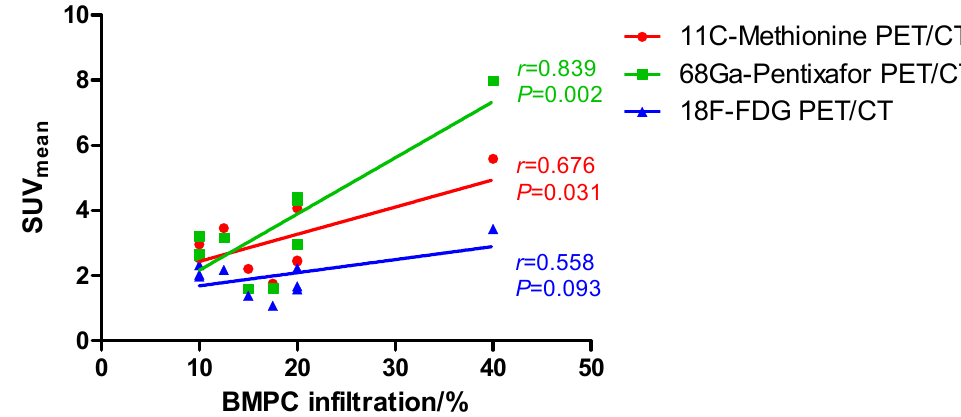
Figure 1. Correlation between bone marrow plasma cell (BMPC) infiltration and mean standardized uptake value (SUV mean ) of lumbar vertebrae (LV) L2-L4 on 11C-Methionine, 68Ga-Pentixafor, and 18F-FDG PET/CT: A significant correlation between BMPC infiltration and SUV mean of LV L2-L4 was shown by 11C-Methionine PET/CT (Pearson’s r = 0.676, p = 0.031, red) and 68Ga-Pentixafor (Pearson’s r = 0.839, p = 0.002, green) PET/CT. In contrast, there was no significant correlation between BMPC infiltration and SUV mean of LV L2-L4 on 18F-FDG PET/CT (Pearson’s r = 0.558, p = 0.093, blue).